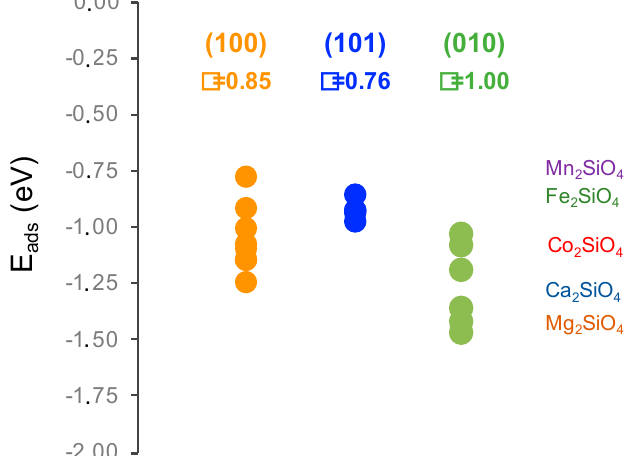
Figure 5. Adsorption energies of water on β -belite surfaces compared to the values reported with DFT for the olivine orthosilicate family [44]. The circles correspond to the adsorption energies calculated in this study and the shadowed region ranges obtained for different water adsorption configurations in Reference [44]. Additionally, the surface energy value ( γ ) is given in J/m 2 .